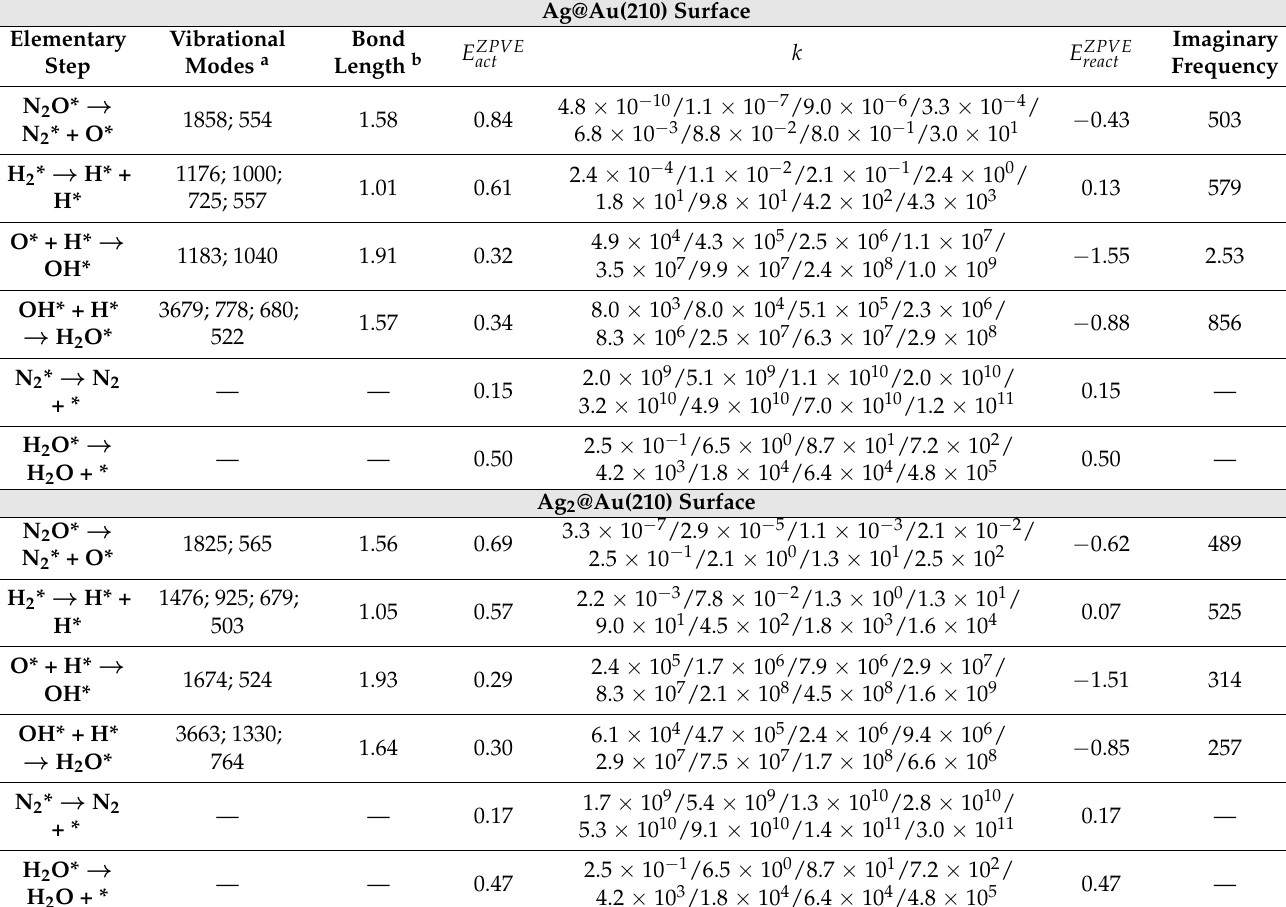
imaginary frequencies (cm − 1 ) for the steps involved in the N 2 O hydrogenation on Ag@Au(210) and Ag 2 @Au(210)